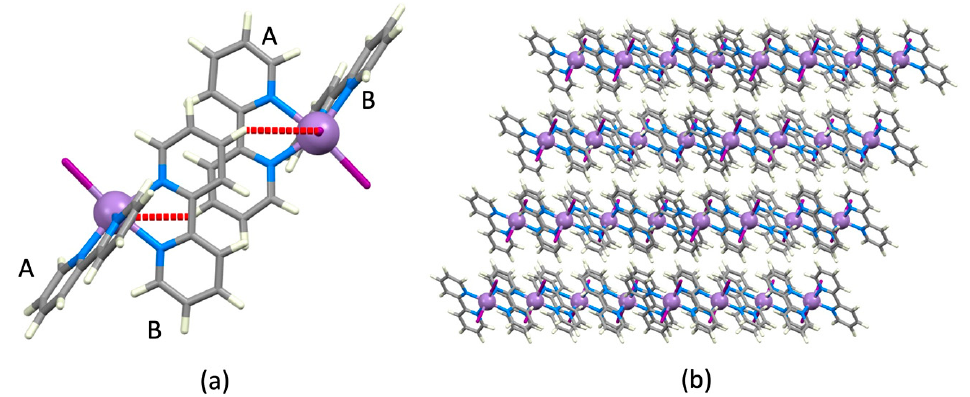
Figure 5. Packing interactions in cis- [Mn(bpy) 2 I 2 ] (CSD refcode ISAFOY01 [14]): ( a ) the basic motif contains a π -stacking interaction and H4...I contacts (in red), and ( b ) assembly of heterochiral layers. The crystallographically independent bpy ligands are labelled A and B.